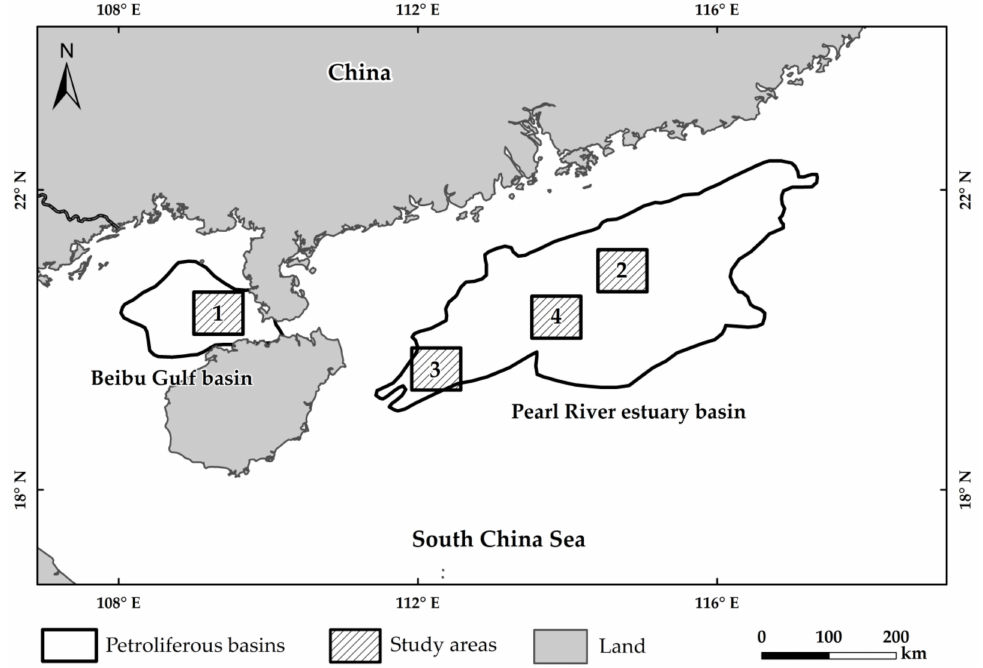
Figure 5. Diagram of the research locations. The gray square in the figure indicates the petroliferous basins, and numbers 1–4 represent regions in the selected study area where the offshore platforms are densely